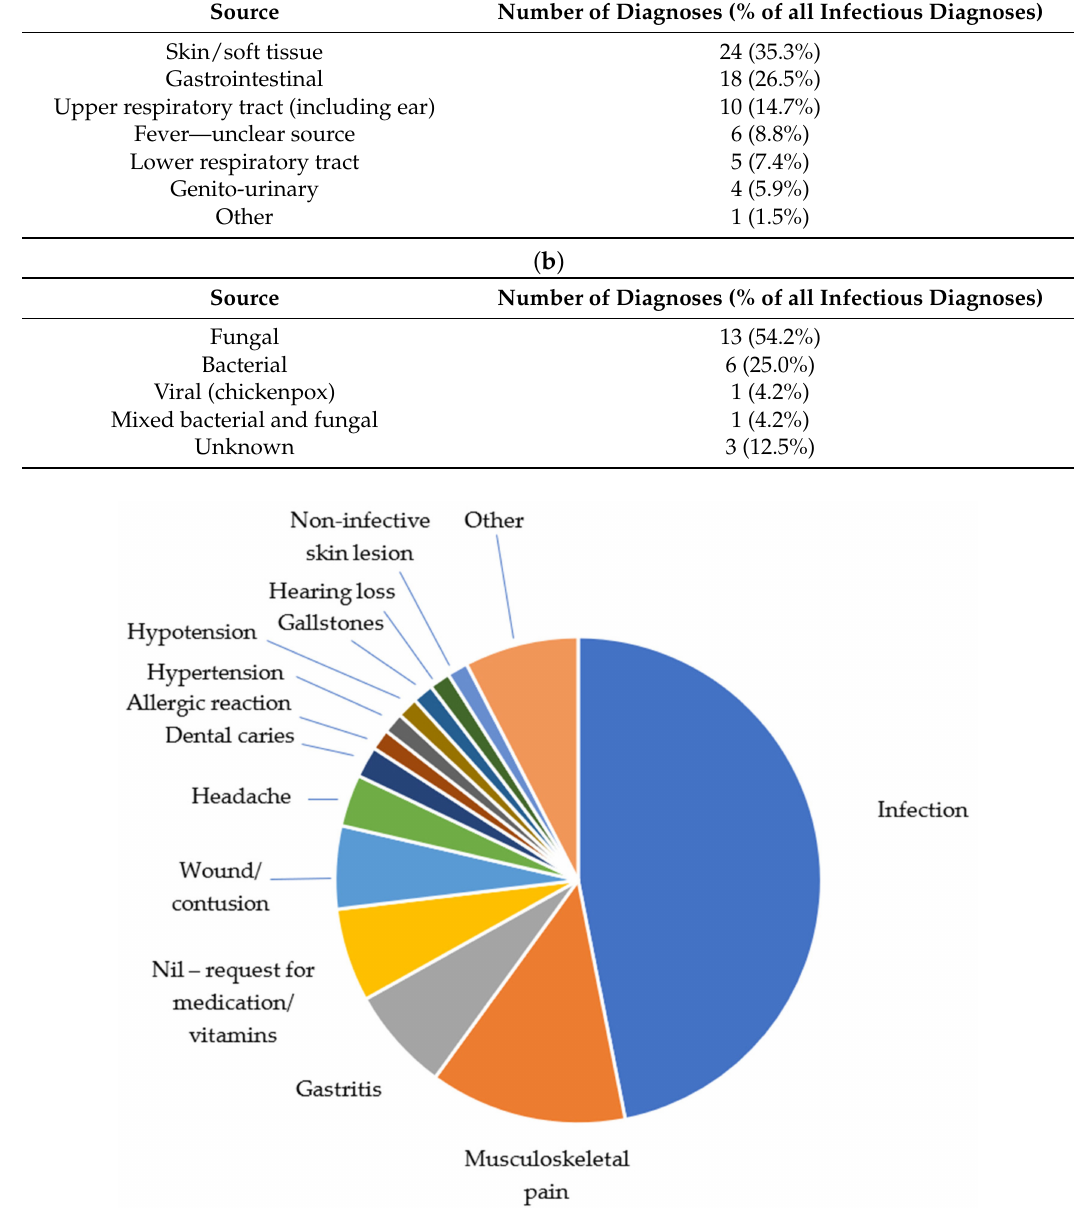
Figure 3. Diagnoses made at the